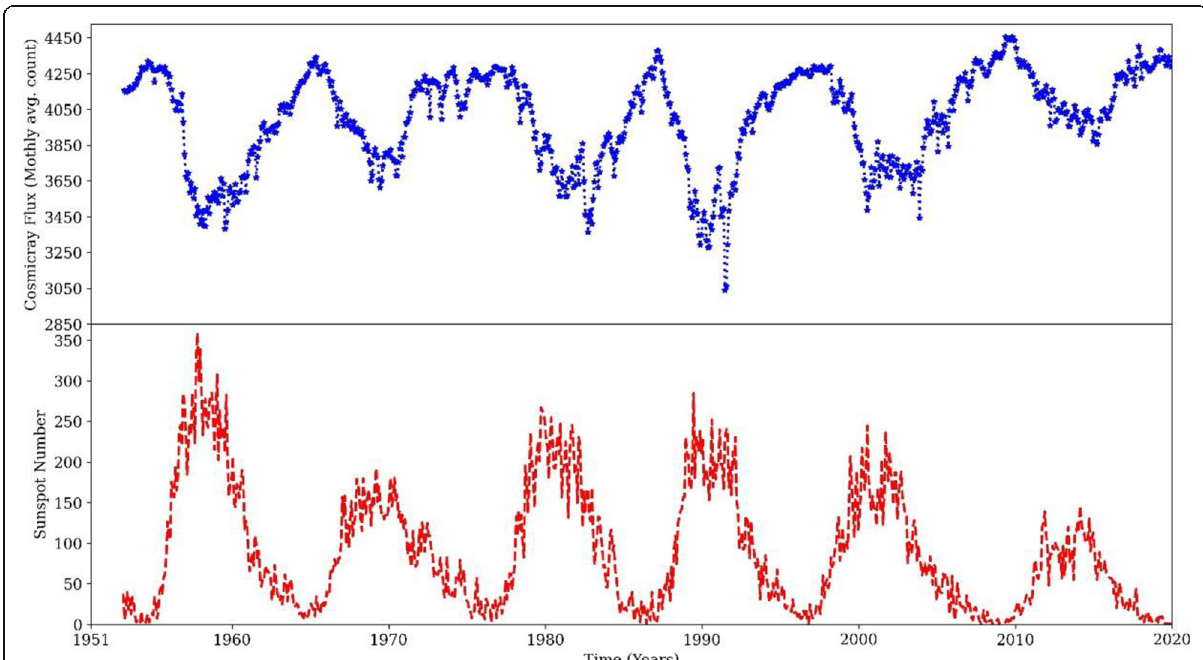
Fig. 10 Modulation of cosmic ray flux at Earth by the solar magnetic cycle. The top panel depicts variations in the flux of cosmic rays as measured by neutron monitors and the bottom panel shows the sunspot time series. At times of strong (low) solar activity, the cosmic ray flux is low (high). This modulation of cosmic ray flux is enabled by the solar magnetic fields via the solar wind — creating the heliospheric open magnetic flux. Monthly averaged cosmic ray flux data is obtained from the World Data Center for Cosmic Rays (WDCCR). For the time period 1953 – 2006, the data is from CLIMAX station, from 2007 to 2017, the data is from FORT SMITH station, and beyond 2017, the data is from BAKSAN station. This composite plot combines cosmic ray flux count from three different stations with different geomagnetic rigidity cutoffs, e.g., CLIMAX (~ 3 GV), FORT SMITH (0.3 GV, viz. polar station), BAKSAN (~ 6 GV). In order to illustrate the overall qualitative trend, the whole time series data is normalized to the cosmic ray flux count of CLIMAX